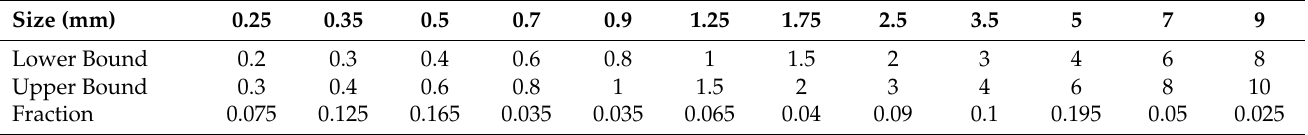
Table 1. Size classes for degradation experiment (Ashida and Michiue [3]).